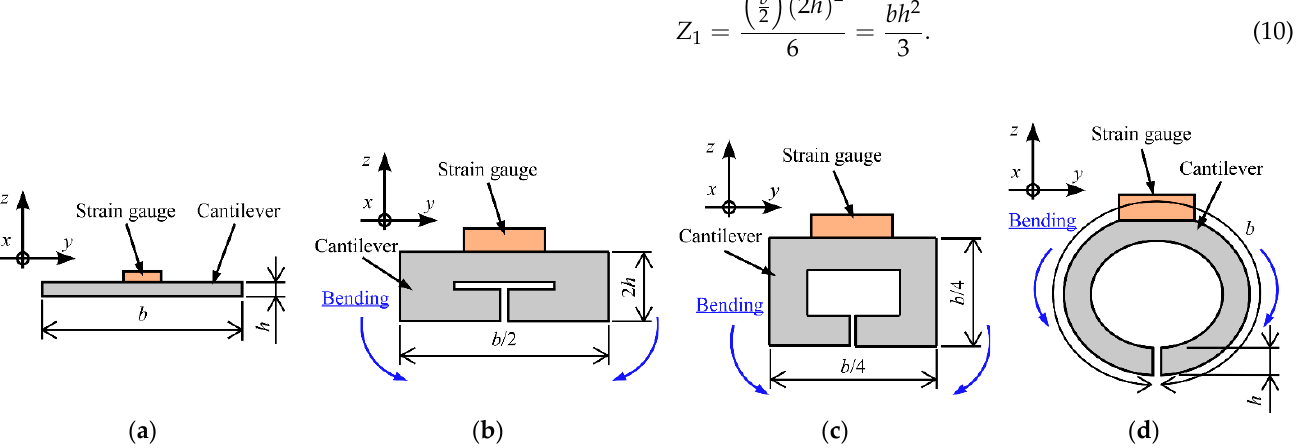
Figure 3. Modification of cross-sectional shape by bending around x -axis. ( a ) Original shape. ( b ) Thick rectangular plate. ( c ) Hollow rectangular column. ( d ) Hollow